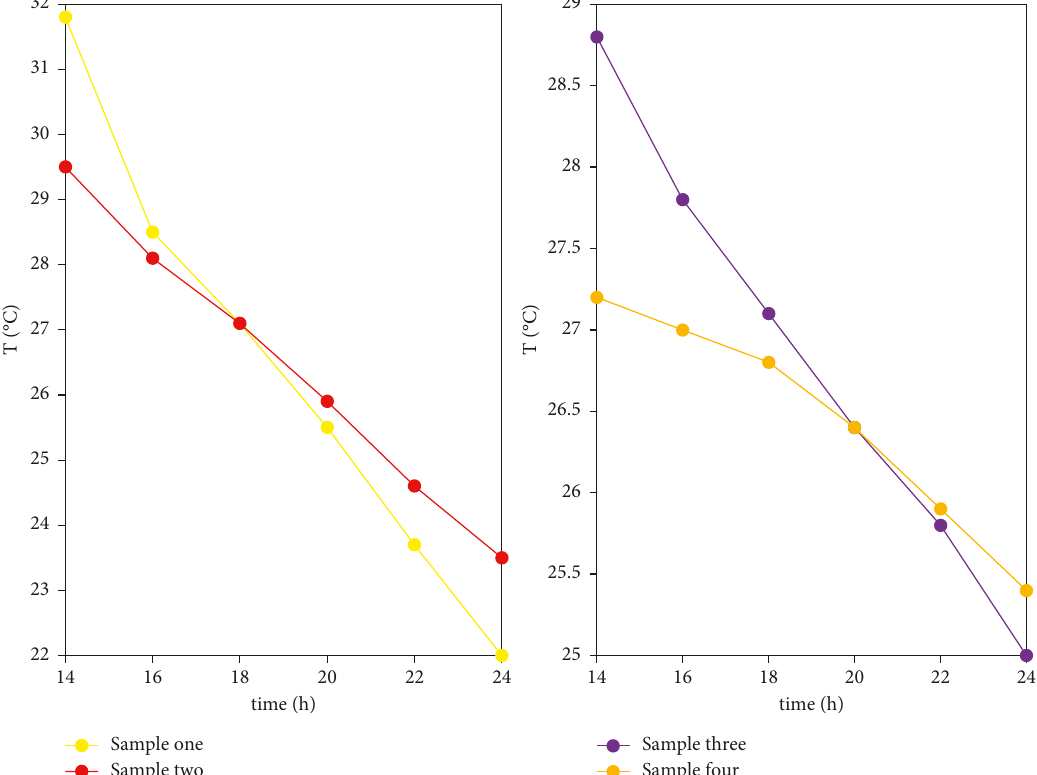
Figure 9: The temperature change diagram of the low temperature side when the samples of the west wall with different ratios are